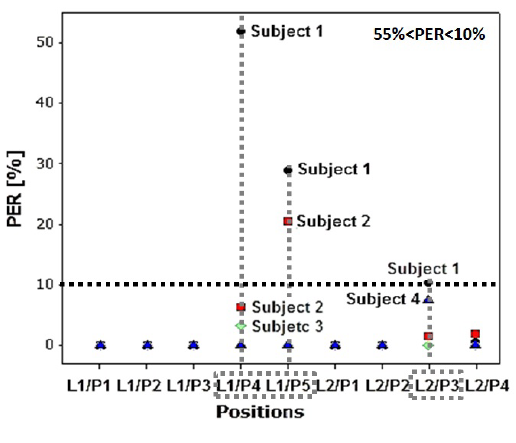
Figure 11. PER vs . Positions at − 7 dBm.